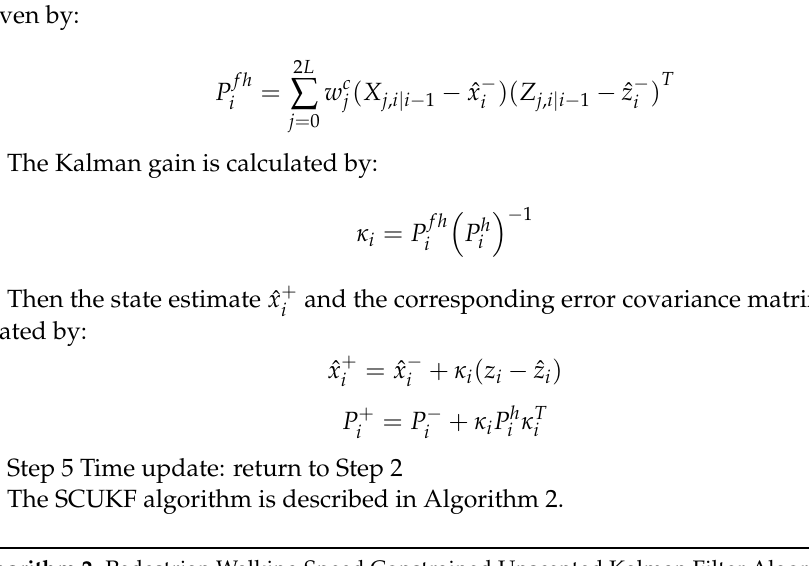
Algorithm 2. Pedestrian Walking Speed Constrained Unscented Kalman Filter